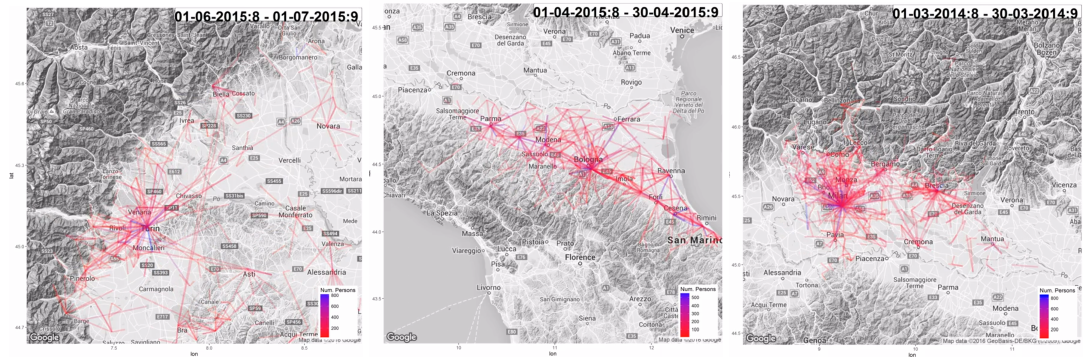
Figure 6. OD Matrices from home-work commute. Blue represent high flows, red low flows. ( left ) Piemonte. ( center ) Emilia Romagna. ( right ) Lombardia.